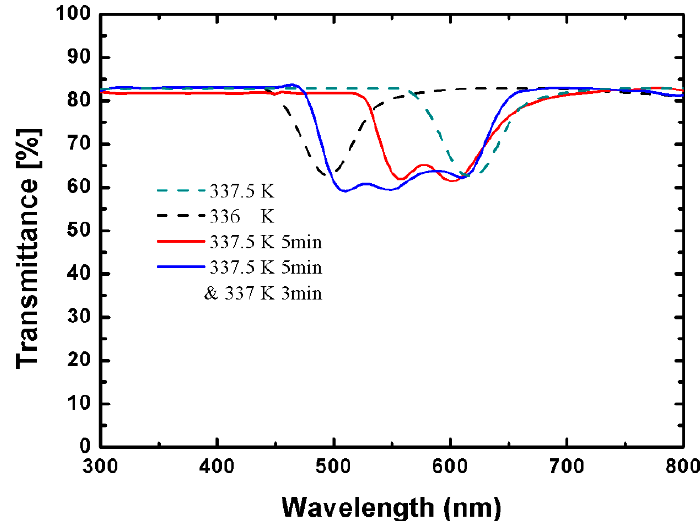
Figure 7. Transmission spectra of the polymer-stabilized blue phase liquid crystal (PSBPLC) filter with sectional polymerization process.